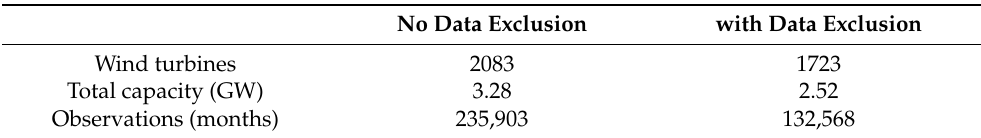
Table 1. Vindstat data used for this study. The excluded data were removed according to “Section 3.3 Data Exclusion”.